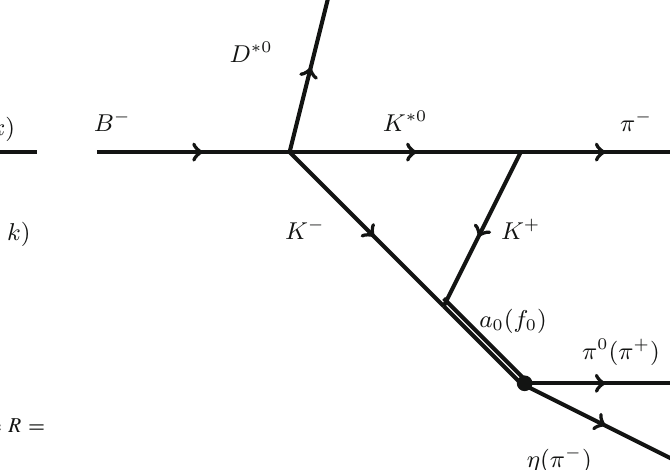
Fig. 2 Diagram for the decay of B − → D ∗ 0 π − ηπ 0 (π + π − )